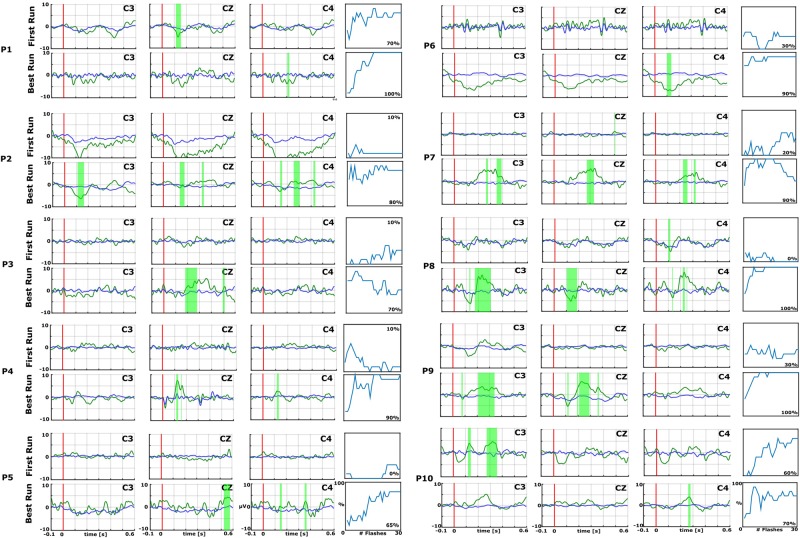
Data from the first (top) and best (bottom) runs for each patient (P1–P10) over central electrode sites (C3, Cz, and C4). In each EP plot, the red line shows stimulus onset, the blue line shows EPs from non-target trials, and the green line shows the EPs from target trials. Green shaded areas are time regions with statistically significant differences between target vs. non-target trials (p < 0.05). The figure to the right of each EP plot shows the classification accuracy over the number of target events. This figure presents the median accuracy for each session. The first run performed before the 10 sessions is compared with the best run during the therapy to highlight the training process.